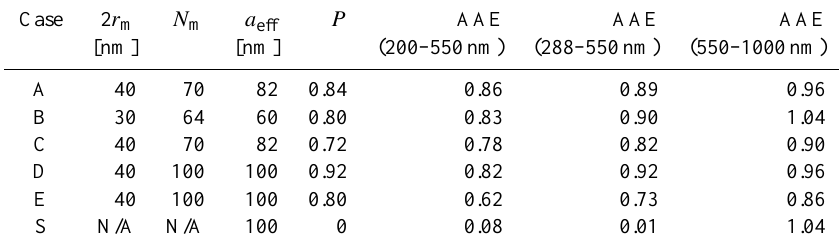
Table 1. Characteristics of the modeled bare BC and optical properties predicted by DDSCAT.